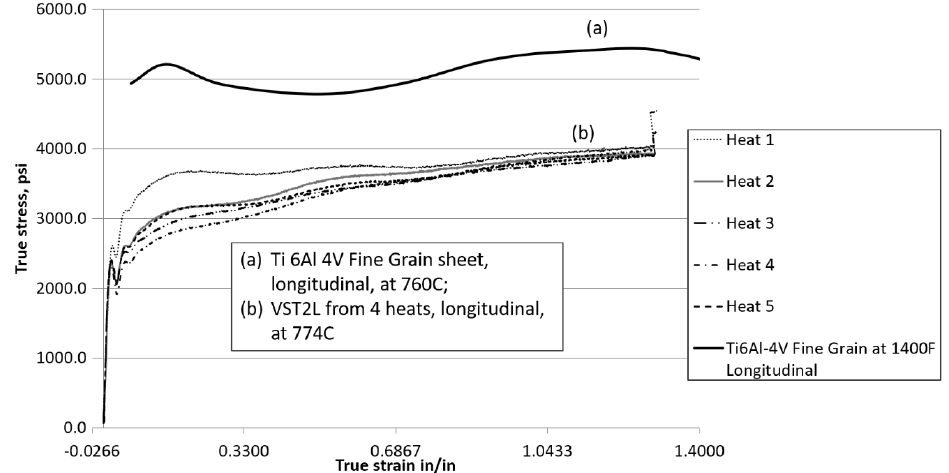
Figure 2. The advantage of VST2L is clear because the flow stress at SPF temperatures for this alloy (775 °C) is significantly lower compared to fine grain Ti-6-4 [22].